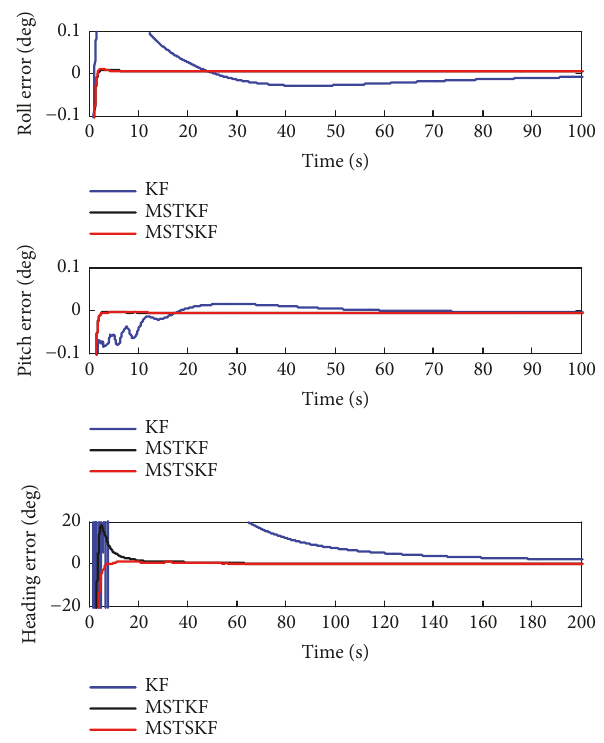
Figure 4: Attitude angle error of the simulation when the initial misalignment angles are large angles.